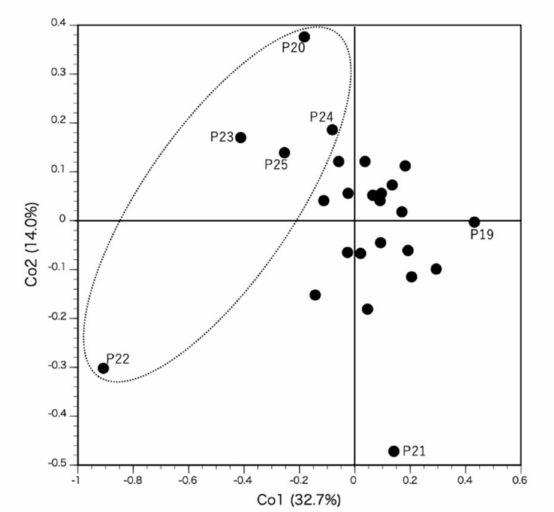
Figure 4. Principle component analysis based on the covariance matrix of the 25 populations. The first (Co1) and second (Co2) axes’ % of variances are in parentheses. Southern range populations are grouped by the dotted line.